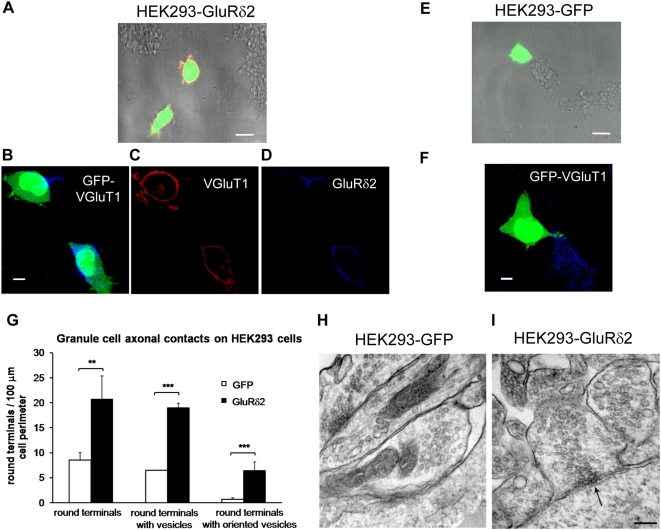
GluRδ2 expressed by HEK293 promotes formation and differentiation of GC axonal contacts.(A–F) Merge of light microphotographs of GCs in coculture with fluorescent 293 cells expressing GFP and GluRδ2 (in red) (A) or GFP alone (E). The corresponding immunofluorescence images are magnified as a single optical section in B–F. The GluRδ2 labeling around the 293 cell perimeter is shown in (C). GluRδ2 expression induces an increase in synaptic contacts, as indicated by the corresponding VGluT1 labeling (B–D). No contacts are visible around the perimeter of the 293-GFP cells; the blue labeling indicates synaptic contacts on a GC cluster (F). (G) EM quantitative analysis of the GC axonal contacts on the 293 cell perimeter. The 293-GluRδ2 cells (black columns) are in contact with a higher number of GC round terminals relative to the control (white columns); in both groups, most of the round terminals contained vesicles. In the 293-GluRδ2 cells, more terminals with vesicles oriented toward the postsynaptic membrane were observed. (H–I) EM images of differentiation of the presynaptic GC terminals induced by 293-GluRδ2 cells. (H) Contact between 293-GFP cell and a round GC terminal containing homogeneously distributed vesicles. (I) A 293-GluRδ2 cell contacted by round GC terminal containing oriented vesicles; the arrow indicates the vesicle cluster. Scale bars: A and E = 20 µm. B-C-D-F = 10 µm. H and I = 0.25 µm. *** p<0.001; ** p<0.01.